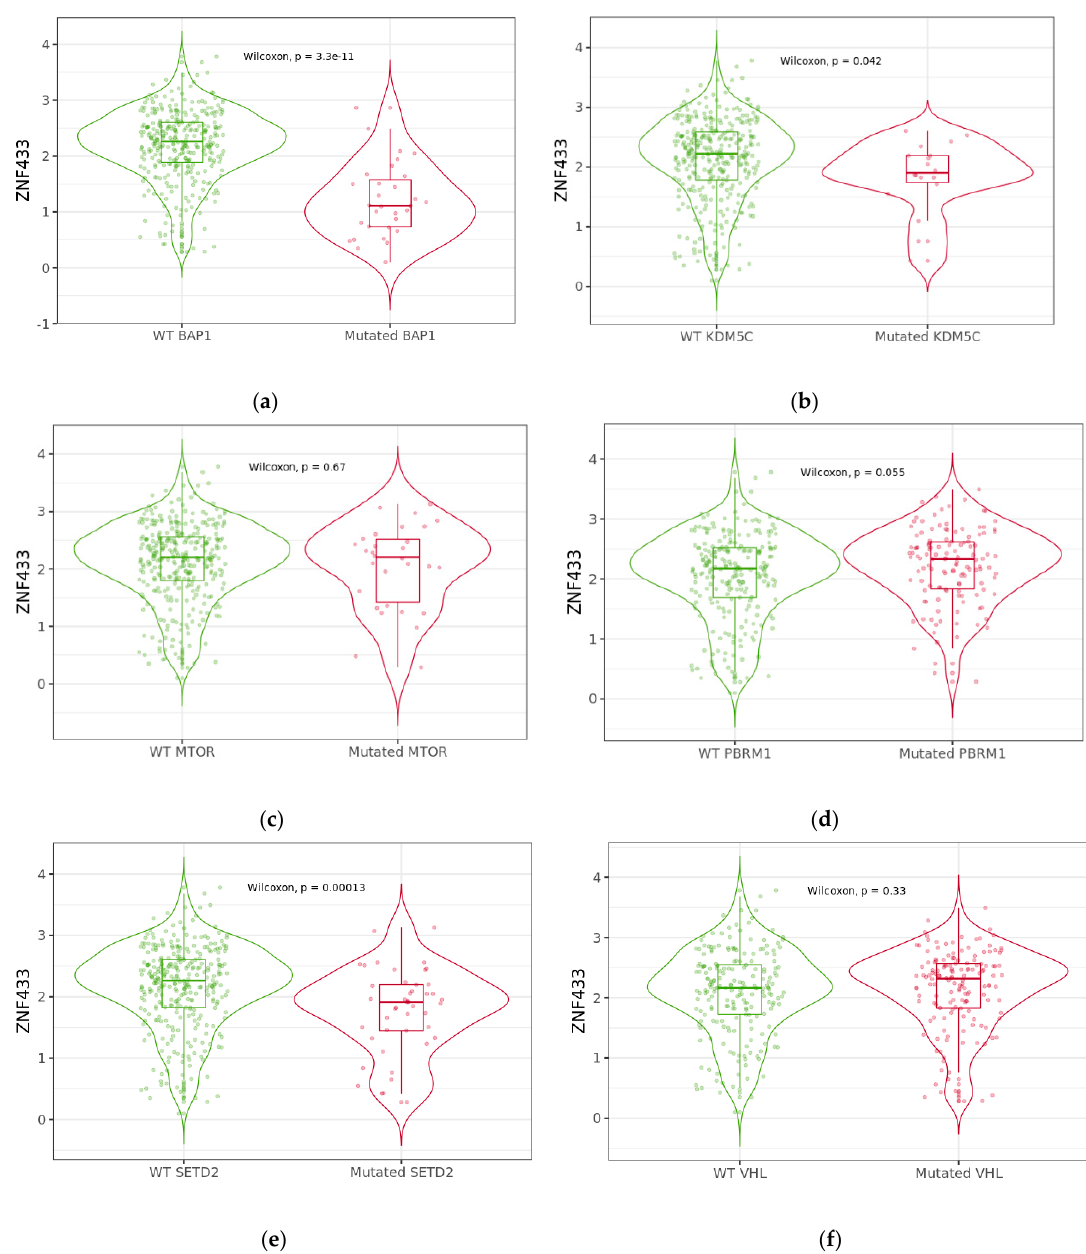
Figure 5. ZNF433 expression based on mutation status of key tumor-suppressor genes (figures a – f ). Violin plots were generated using TIMER2.0 (http://timer.cistrome.org, accessed on 8 May 2021) to analyze ZNF433 expression between mutation status of the most frequently altered genes ( a ) BAP1, ( b ) KDM5C, ( c ) MTOR, ( d ) PBRM1, ( e ) SETD2, and ( f ) VHL that are associated with clear-cell renal cell carcinoma. ZNF433 expression was significantly altered in the presence of BAP1, KDM5C and SETD2. Expression analysis was conducted using RNAseq sample data ( n = 367) derived from TCGA datasets. Abbreviations: BAP1, BRCA1 associated protein-1; KDMC5, lysine-specific demethylase 5C; mTOR, mechanistic target of rapamycin kinase; PBRM1, polybromo 1; SETD2, SET domain containing 2, histone lysine methyltransferase; VHL, von Hippel–Lindau tumor